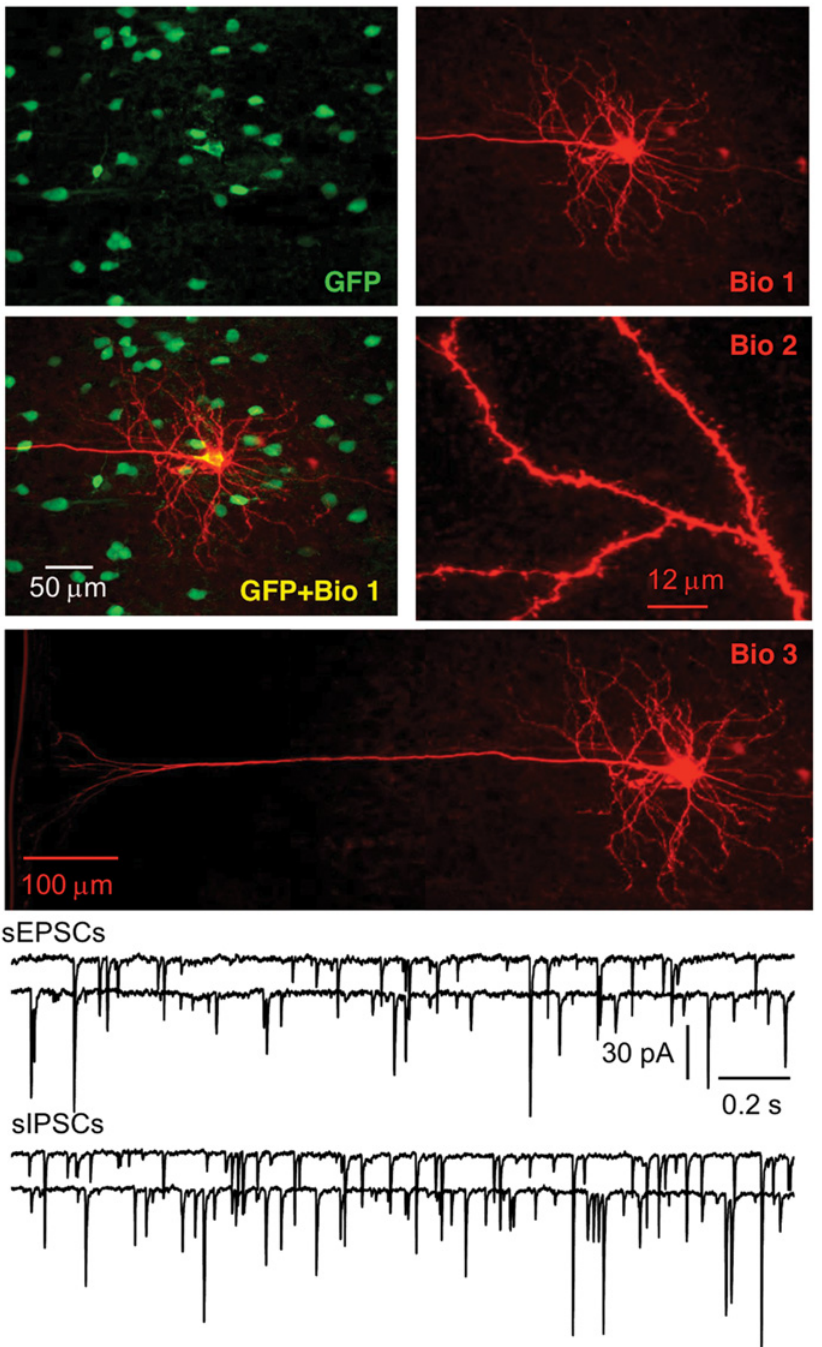
Fig 5. Physiological integration of hNPC-derived pyramidal neurons in the cortex. Human NPCs developed into neurons with a typical pyramidal soma, a long and thick apical trunk, and dendritic spines. Spontaneous IPSCs and EPSCs are shown from two pyramidal